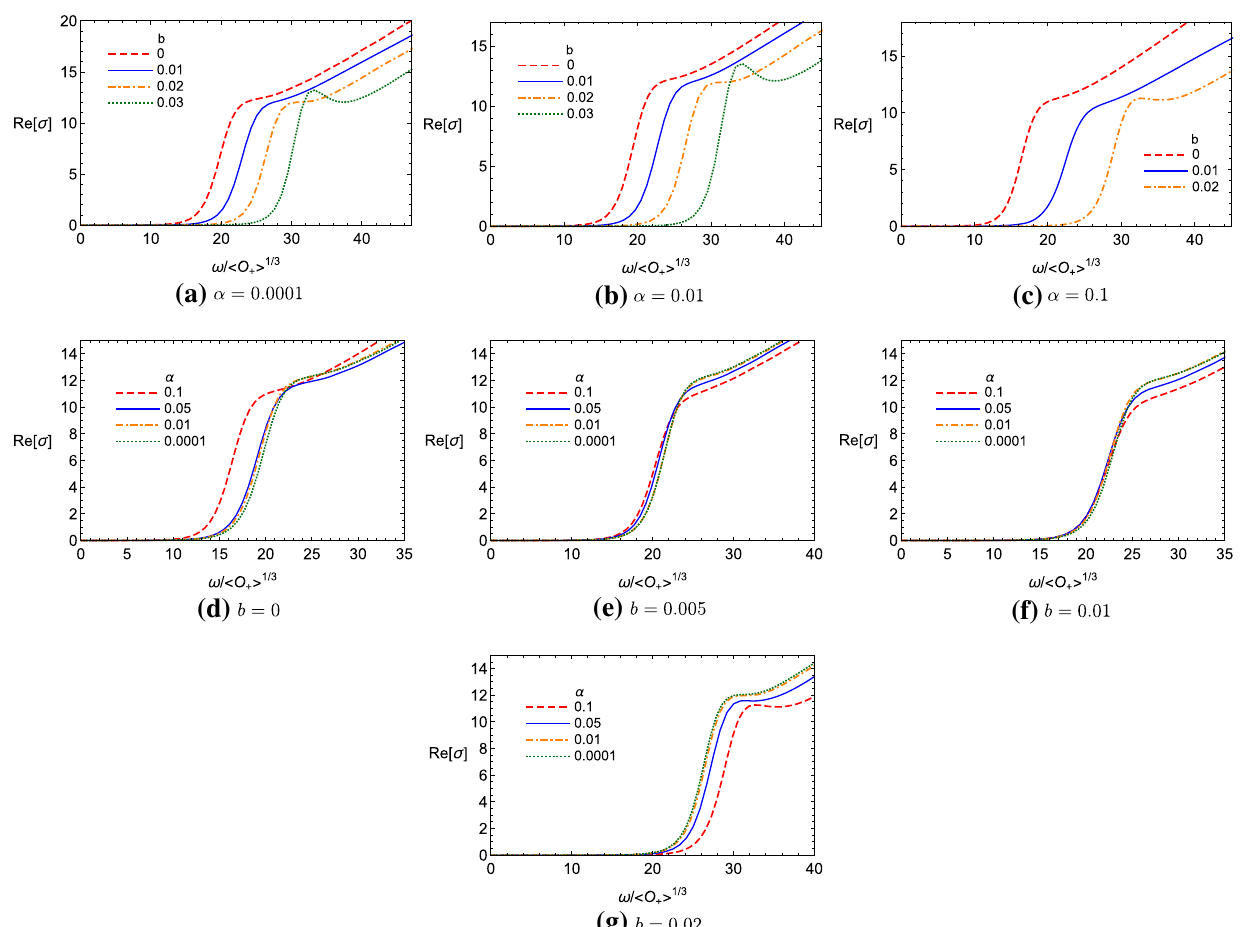
Fig. 6 The real part of the conductivity as a function of ω/ < O + > 1 / 3 , at low temperatures, around T ≈ 0 . 1 T c value of b , the minimum of Im [ σ ] increases with increasing α , while for a fixed value of α , it increases with increasing b